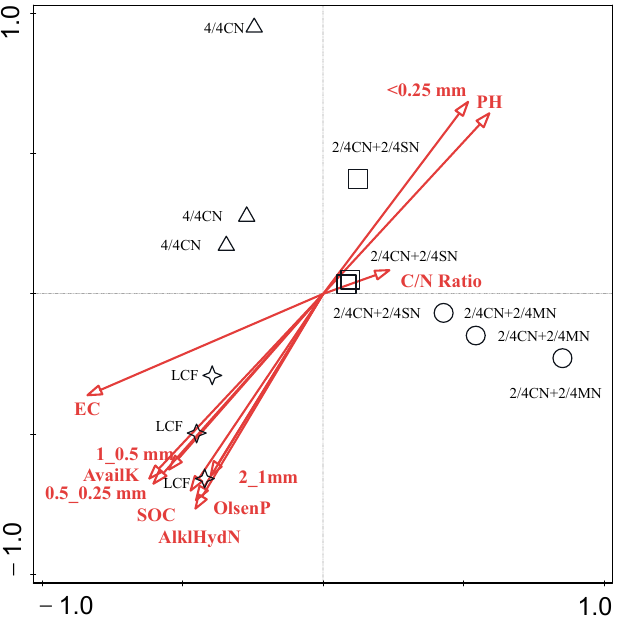
Figure 5. Redundancy analysis of the relationships between soil properties and soil bacterial on genus level. CN: chemical nitrogen; MN: swine manure nitrogen; SN: maize straw nitrogen; LCF: local conventional fertilization.